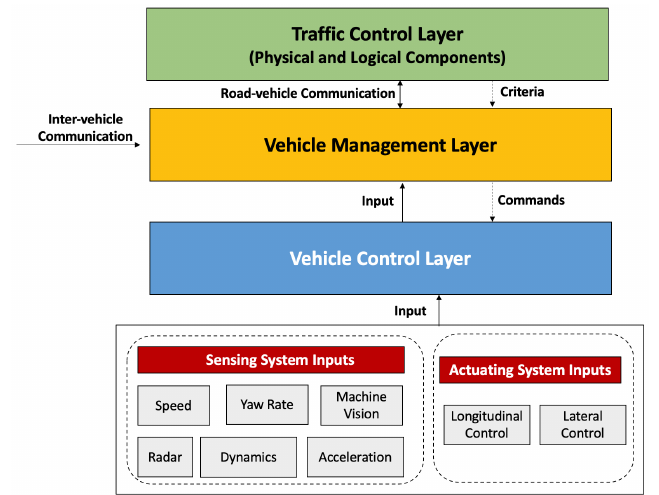
Figure 2. Layered architecture for